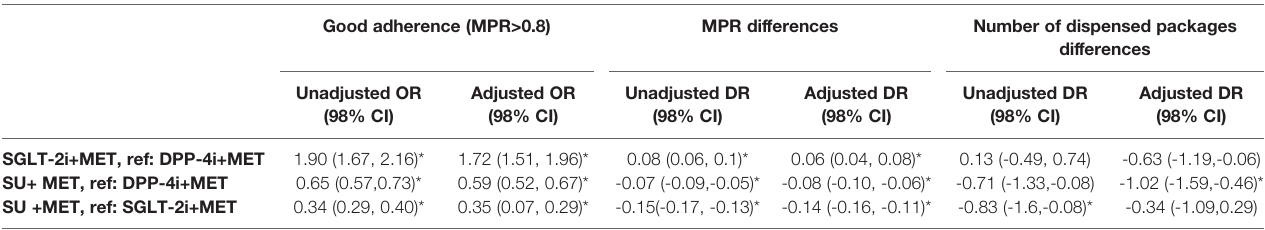
TABLE 2 | Odds ratios for good adherence, MPR differences and number of dispensed packages among the cohorts. Good adherence